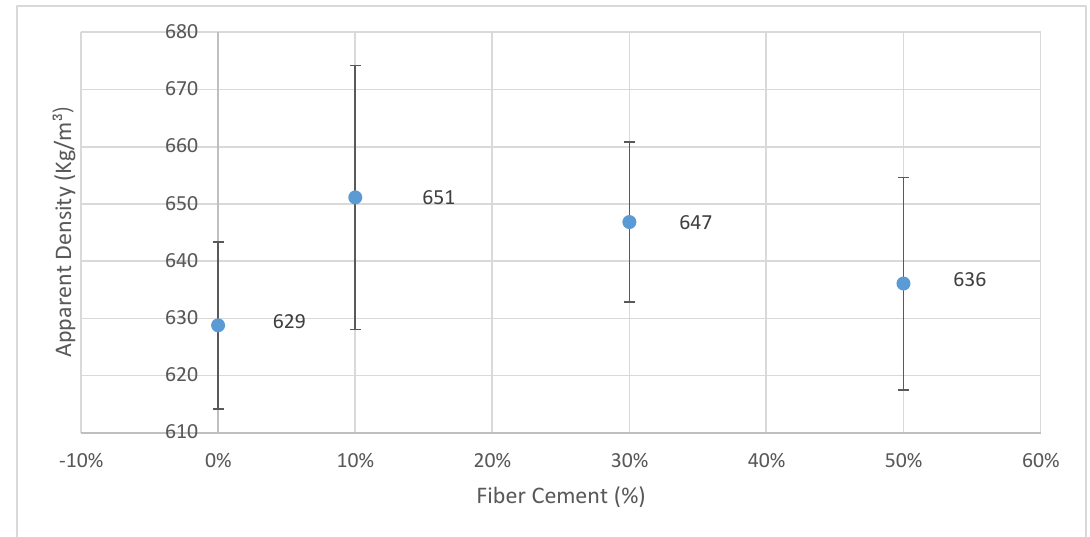
Figure 6: The density of geopolymer foams with increasing basalt waste fibre concentration at room temperature.